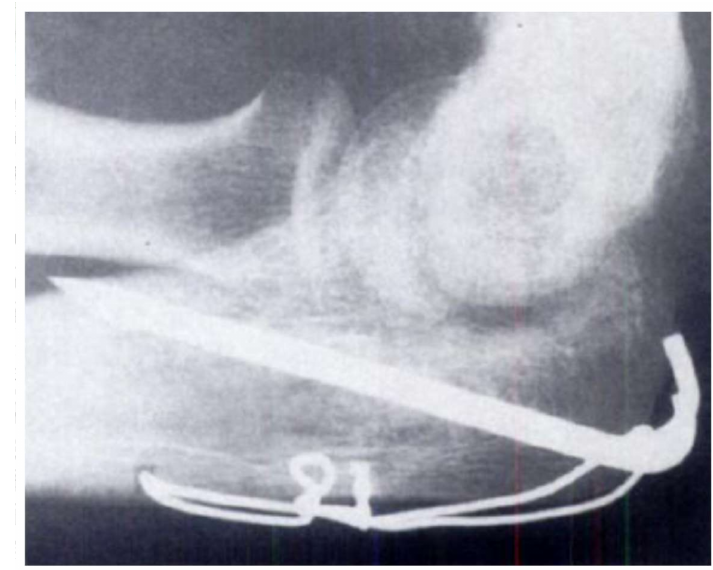
Figure 5. The radiograph shows tension band wiring used to repair an olecranon fracture, reproduced with permission from [76], The Radiological Society of North America (RSNA ® ),